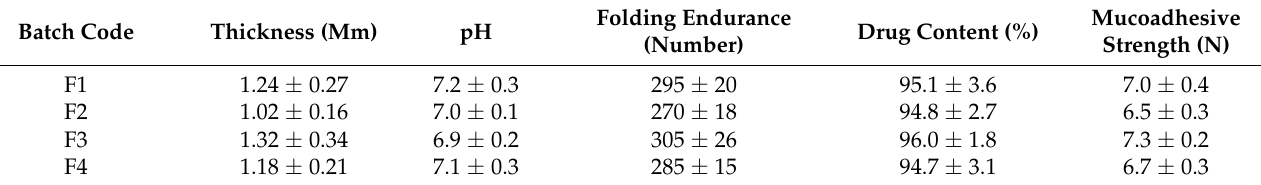
Table 3. Characteristics of prepared rizatriptan buccal